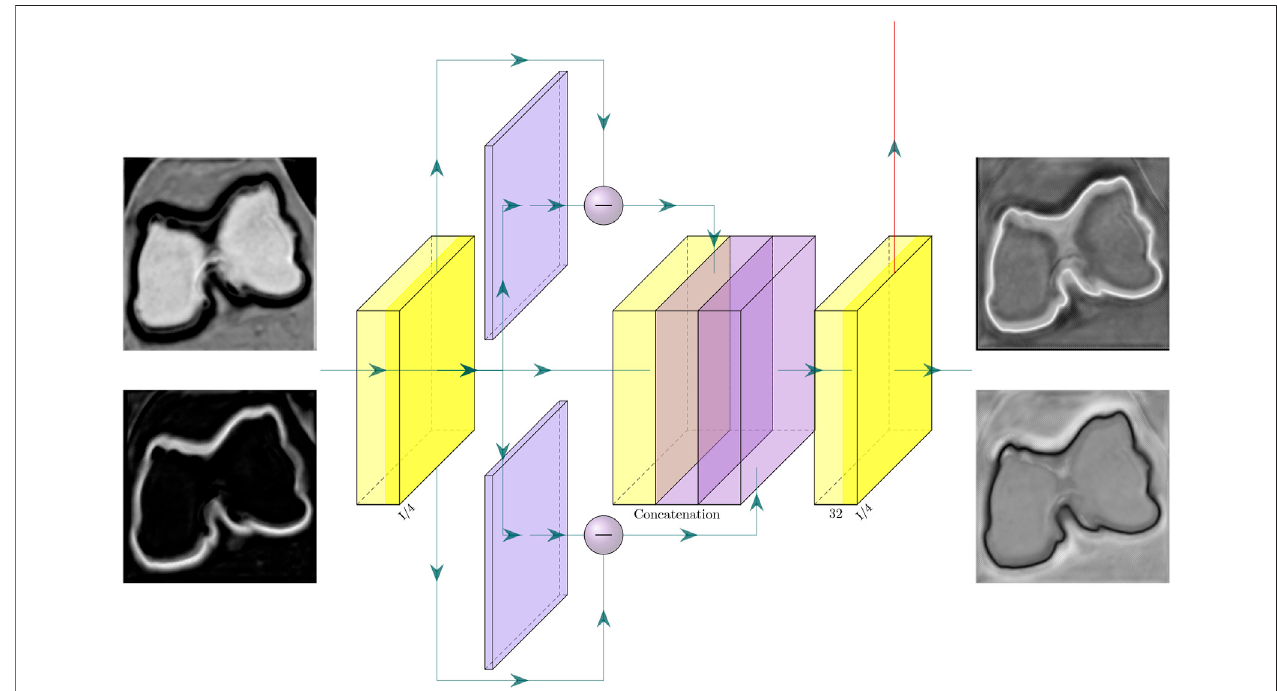
FIGURE 2 | Pyramidal edge extraction (PEE) module in one level of the edge decoding branch. For sake of clarity, only two pyramid-edge fi lters were considered. The input to the PEE module consists of the set of activation maps (for simplicity here only 2 were depicted), being the output of the previous layer in the contour-aware decoding branch. Likewise, the module output consists of theset ofactivation maps (again for simplicity here only 2 were depicted),which aredeliveredto the nextlevel of the contour-aware decoding branch (horizontal arrow), and to the same level of the region-aware decoding branch (vertical arrow).